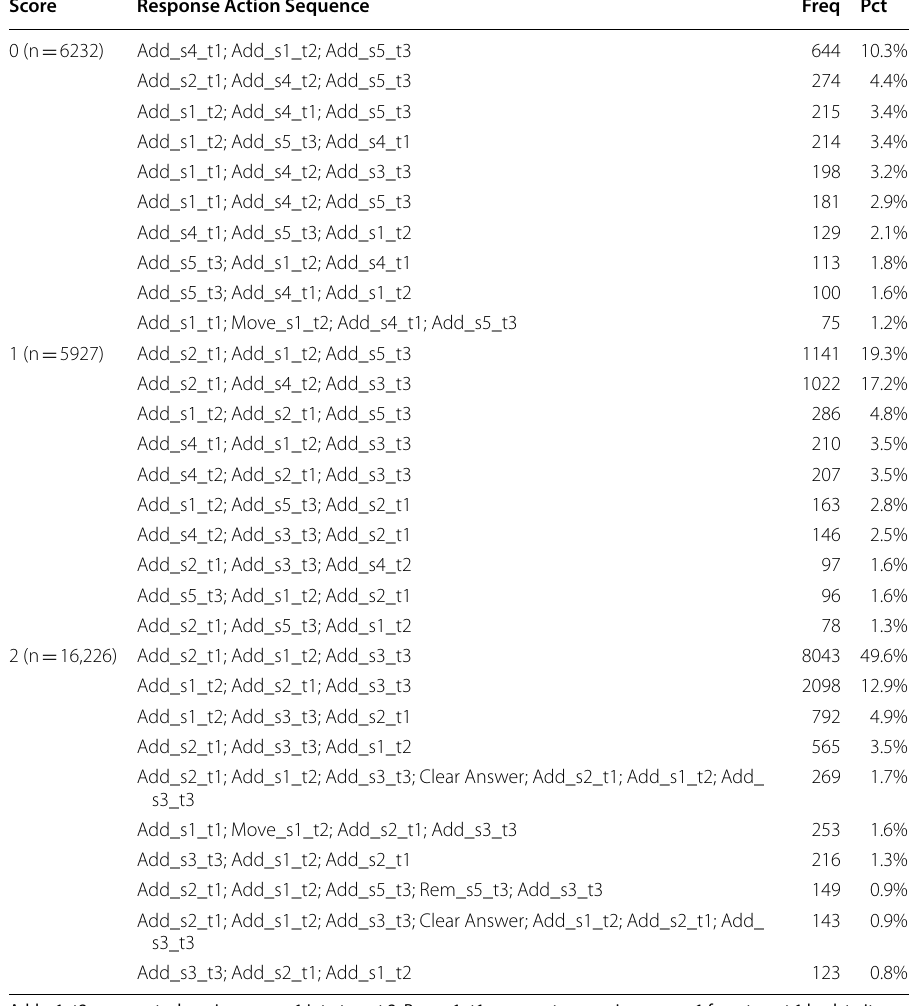
Table 2 Top ten most frequent response sequences among students who received different scores on the G4 item and their frequency and proportion within each score